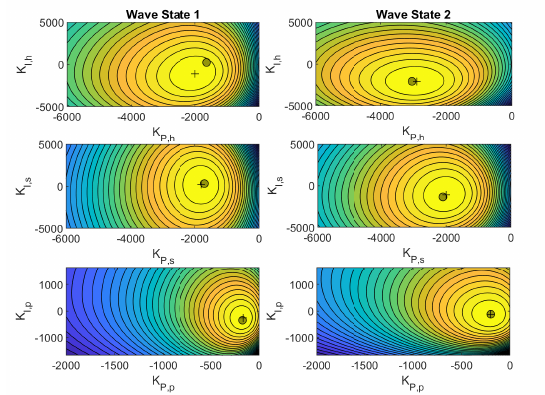
Fig. 9: The WEC power surface as a function of gain tuning for each degree of freedom and wave state for the 2A-10A concatenated wave. Optimum absorbed power is the brightest yellow. The post-calculated op- timal gain combination for the sea state is shown as the + , while the combination of gains suggested by the autotuner at the investigated instant is shown by the transparent dot.